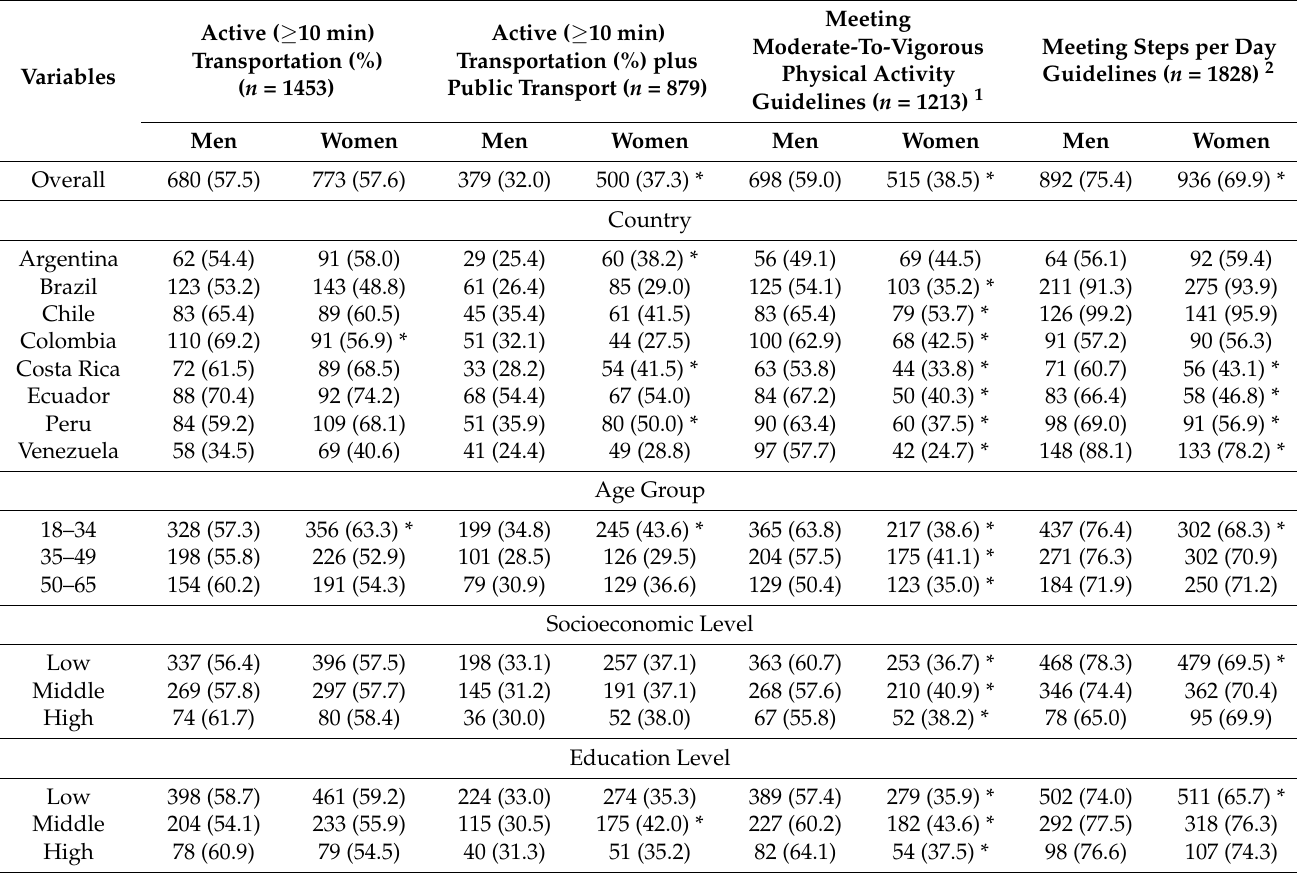
Table 2. Descriptive characteristics ( n (%)) of participants by active transportation (also plus public transport), meeting moderate-to-vigorous physical activity and steps per day